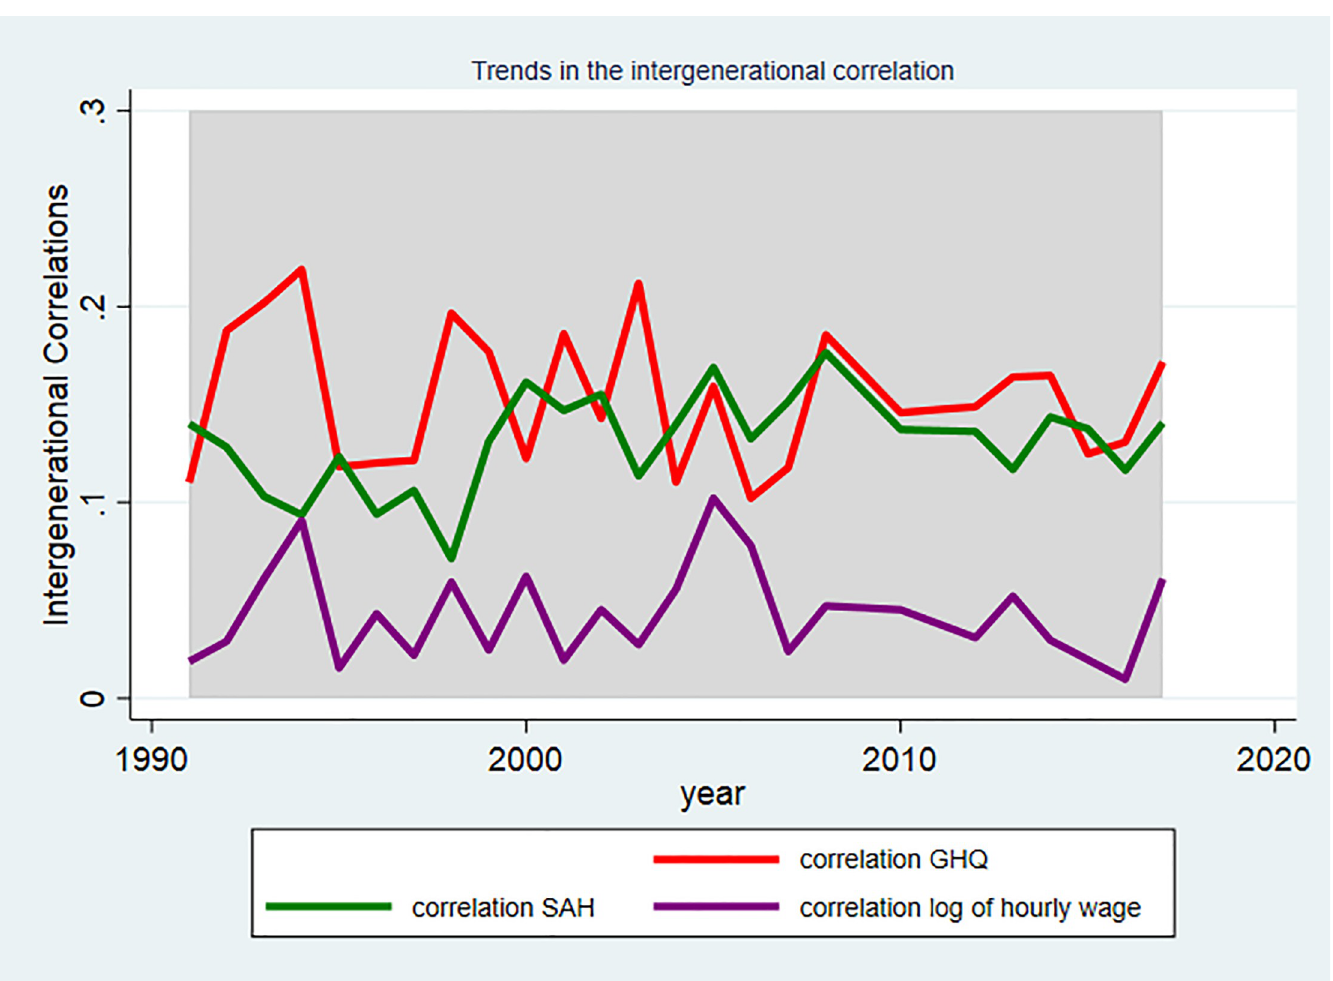
Fig 2. Trends in the intergenerational correlation in SAH, GHQ, and log of hourly wages between 1991–2017.